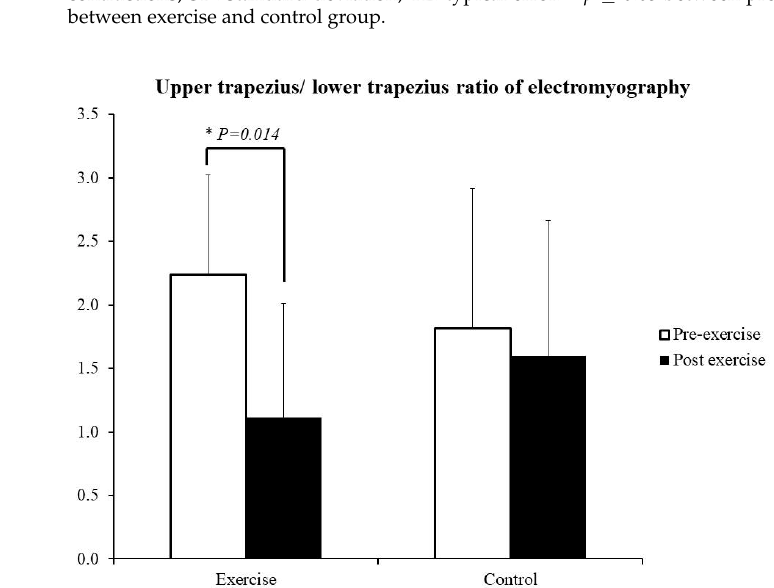
Figure 3. Upper trapezius/lower trapezius ratio as indicated through electromyography. * p ≤ 0.05 between pre- and post-exercise. Table 1. Shoulder angle (degree).